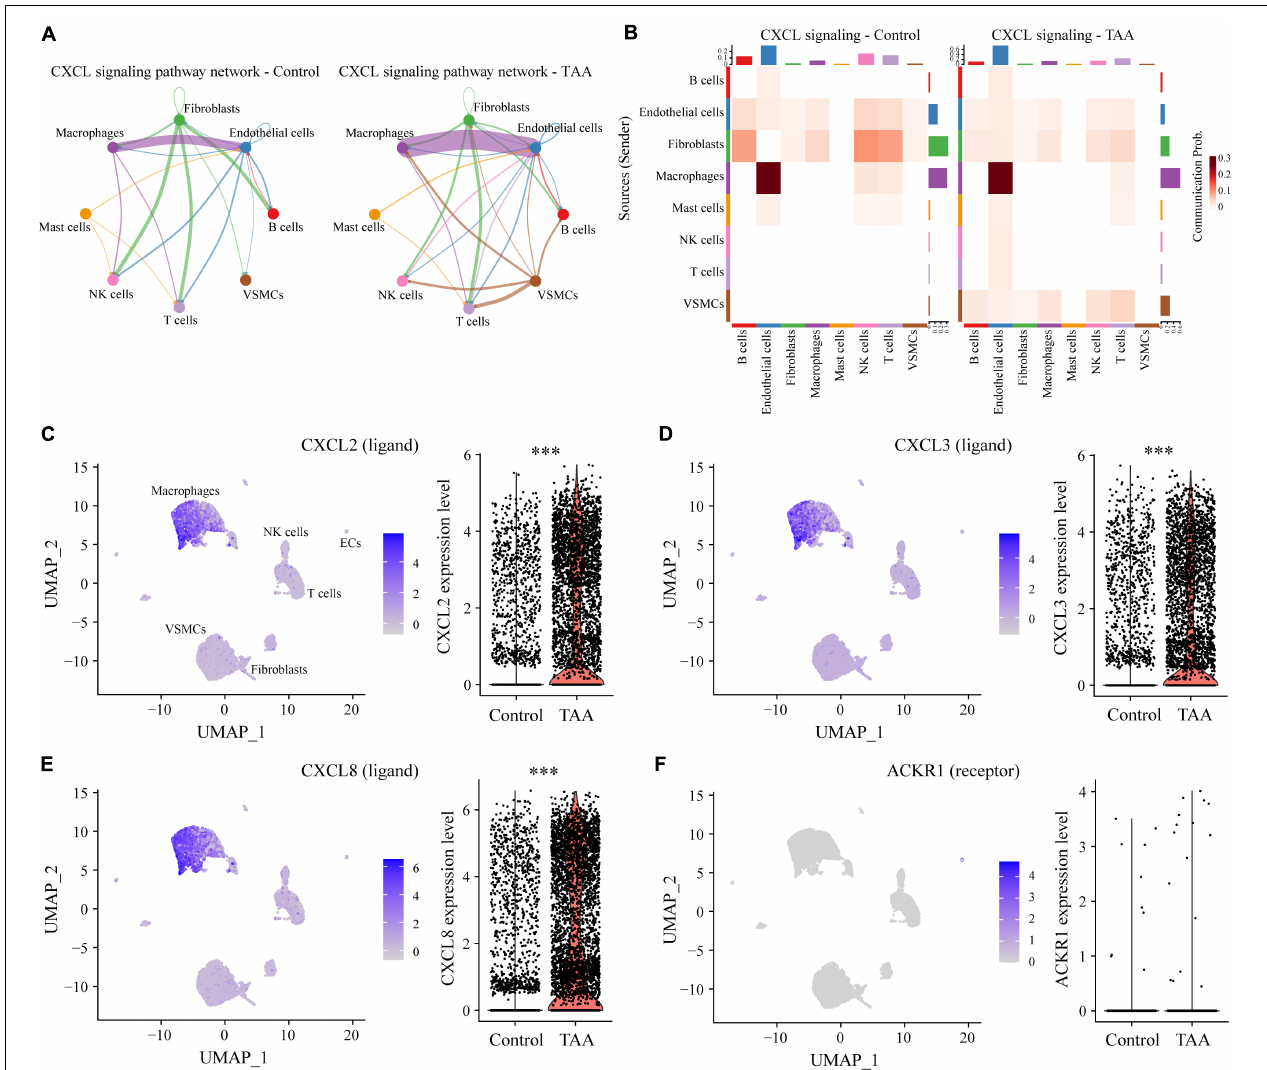
FIGURE 6 | Representative signaling sent by macrophages. (A) Circular network plot showing the network centrality analysis of the CXCL signaling pathway. (B) Heatmap plot showing the communication probabilities of the CXCL signaling pathway among the cells in control and TAA samples. (C–F) UMAP and violin plots displaying the expression levels of CXCL2 (C) , CXCL3 (D) , CXCL8 (E) , and ACKR1 (F) in all aortic cell clusters. ∗∗∗ P <